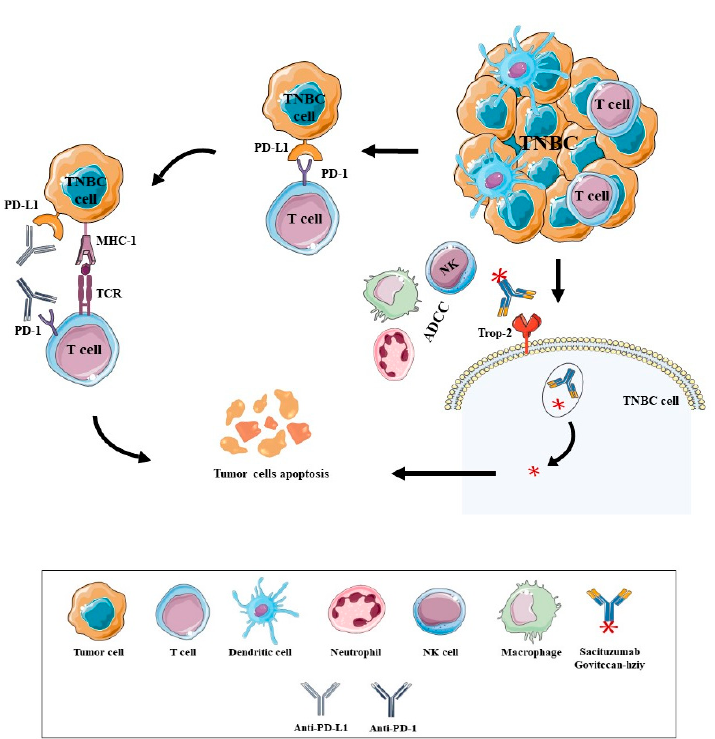
Figure 2. Immunotherapy modalities approved as a treatment for patients with TNBC and their mechanism of action. The tumor cells can escape from host immune surveillance by the expression of immune checkpoint proteins, like PD-L1, that when bound to PD-1 expressed in active T cells, cause the decrease of T cell proliferation and survival. One of the strategies to restore antitumor immune responses and promote immune-mediated elimination of cancer cells are the ICI. Nowadays, Pembrolizumab (anti-PD-1) and Atezolizumab (anti-PD-L1) are two ICI approved for TNBC patients that when bound to their target blocks the interaction of PD-1 and PD-L1 and allows the CTL to eliminate the tumors cells. The Sacituzumab Govitecan-hziy was also approved as a treatment for TNBC patients, an ADC formed by the mAb hRS7 directed for antitrophoblast cell-surface antigen 2 (Trop-2), that was expressed in 90% of TNBC tumors, conjugated with SN-38, a topoisomerase I inhibitor. The hRS7 binds to the Trop-2 expressed in TNBC cells and the ADC goes into the cell by receptor-mediated endocytosis. The lysosomes degrade the mAb, realizing the SN-38 and inhibiting the topoisomerase I, causing the cell cycle arrest and tumor cell apoptosis. It was also demonstrated that Sacituzumab Govitecan-hziy promotes ADCC that kills the tumor cells that express the Trop-2. Abbreviations are as follows: Triple-Negative Breast Cancer (TNBC), Programmed Cell Death Protein-1 (PD-1), Programmed Cell Death Protein Ligand 1 (PD-L1), Major